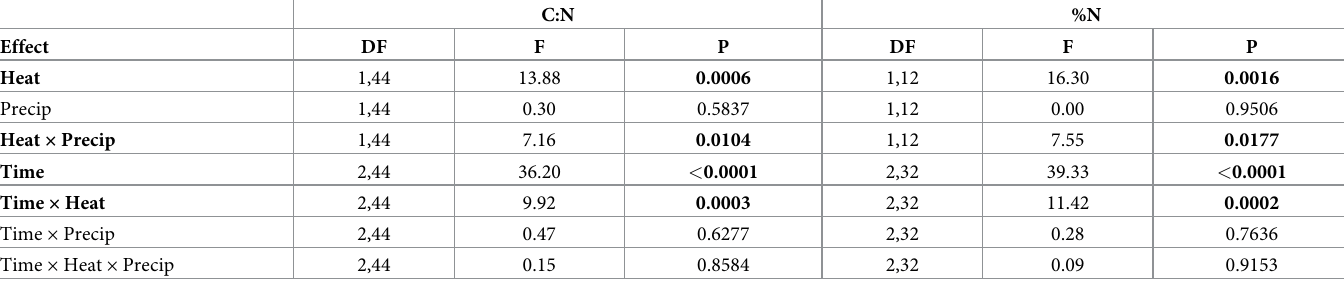
Table 4. ANOVA table for C:N and %N of bulk forage samples from the 2013 harvests. Degrees of freedom are shown as numerator, denominator. Bolding indicates significance. C:N